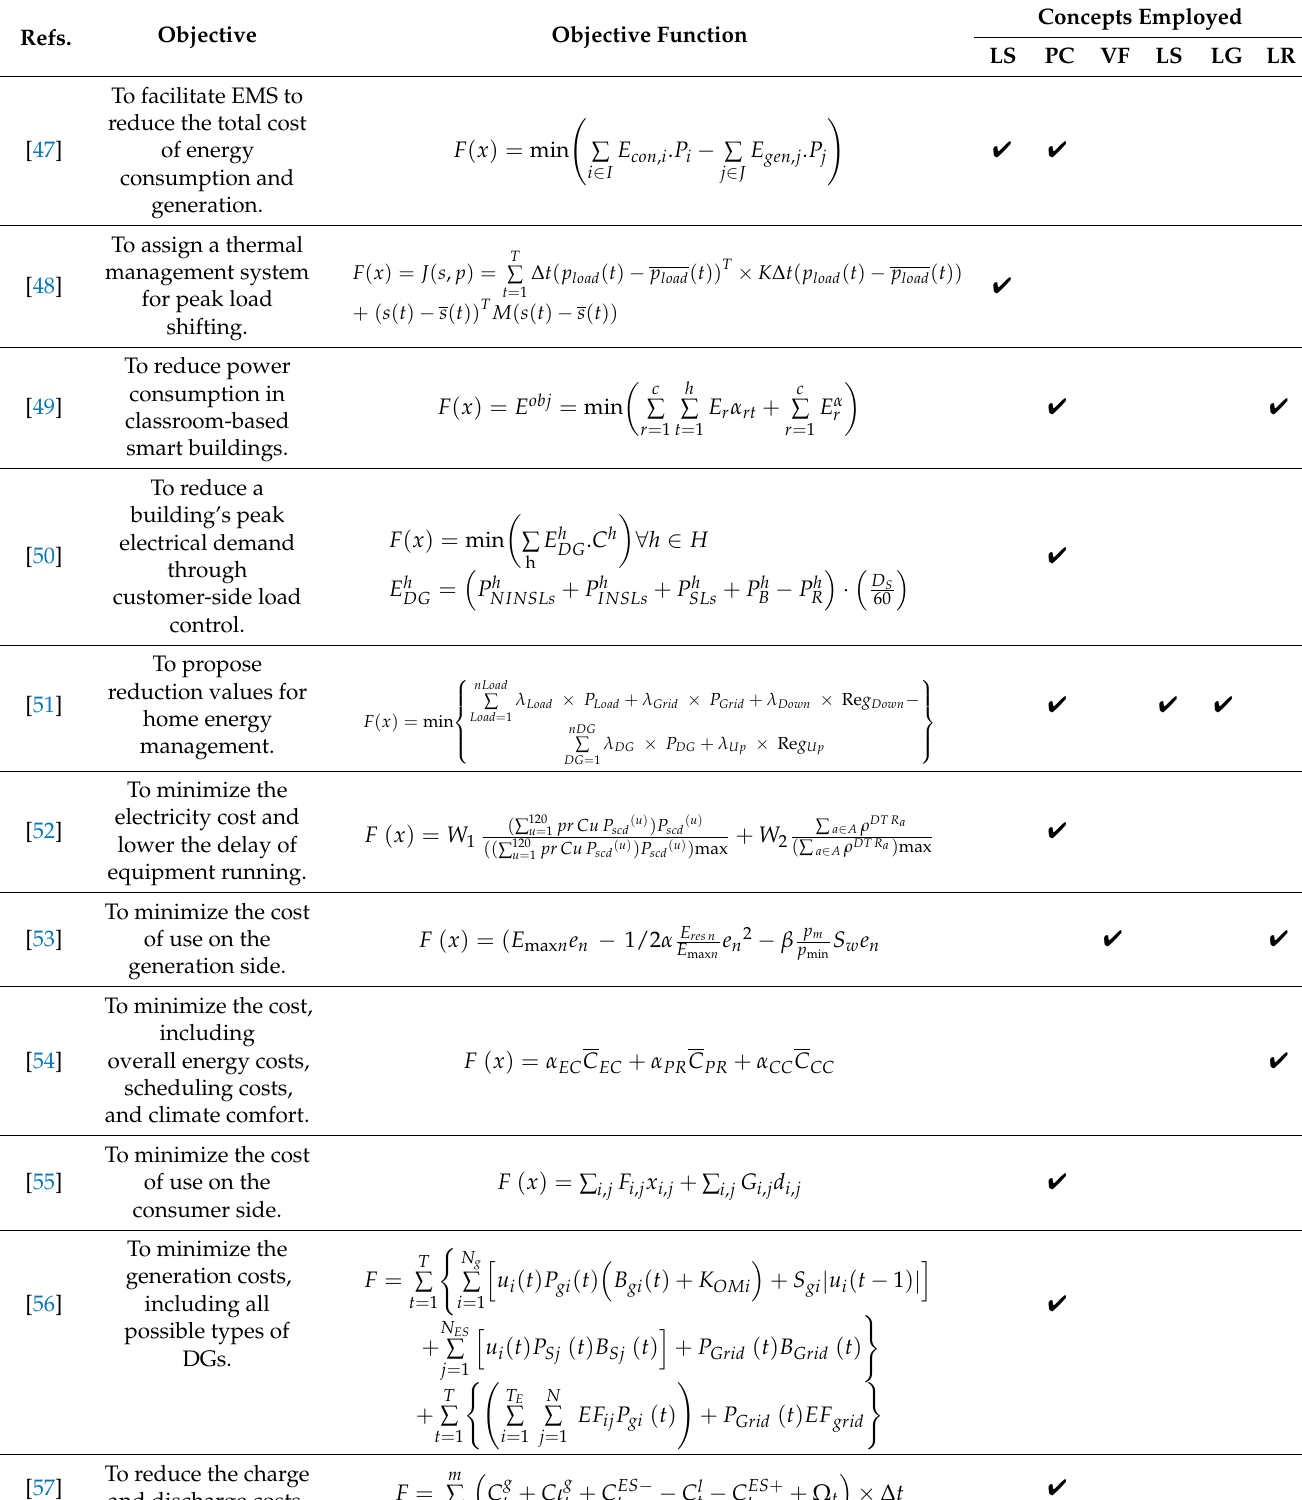
Table 3. Classical technique-based single objective